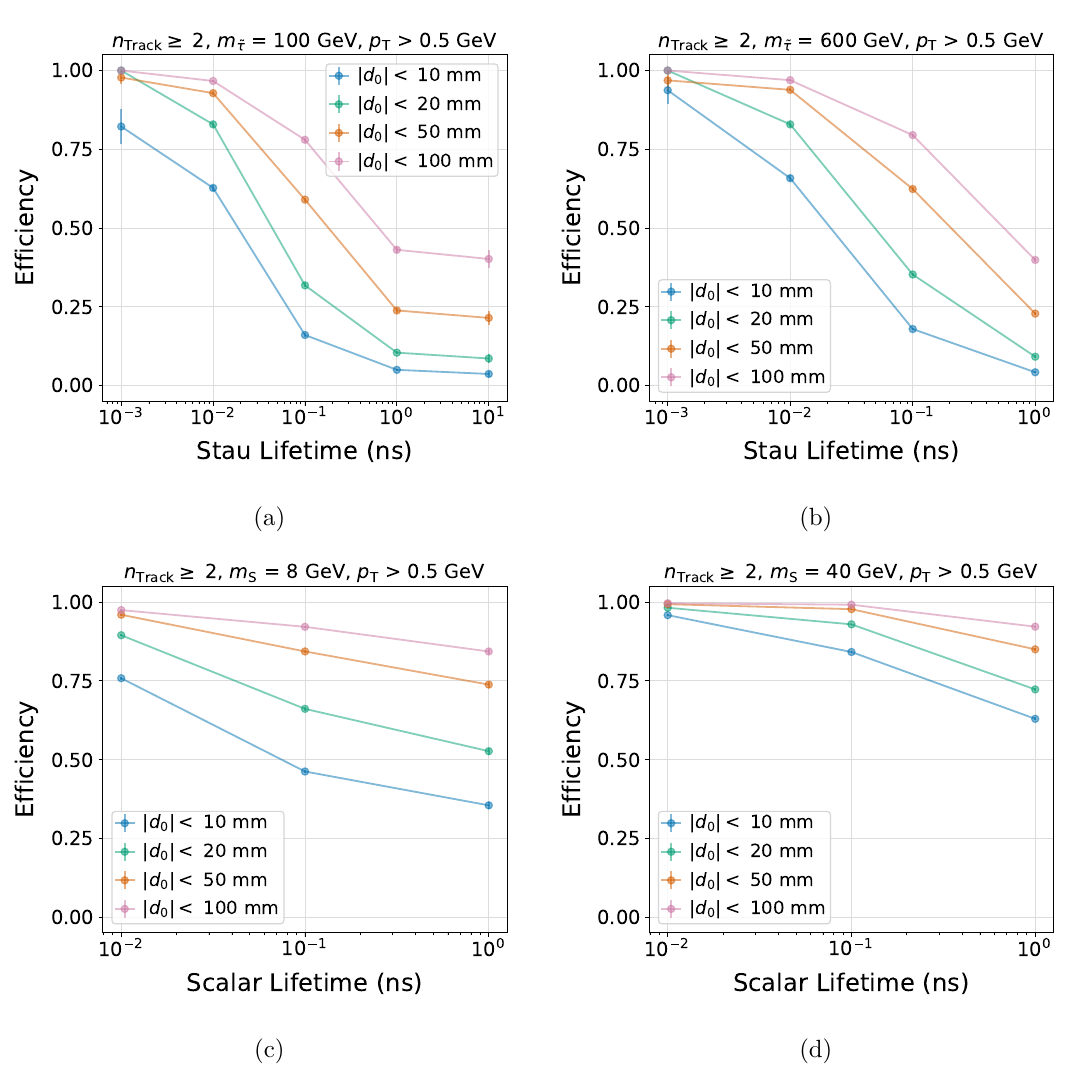
Figure 28. Trigger efficiency as a function of lifetime at a range of maximum track | d 0 | values for staus with masses 100 GeV (c) and 600 GeV (b) and a Higgs portal with scalar masses 8 GeV (b) and 40 GeV (d). Only displaced tracks produced in the long-lived particle decay are considered. Effects of the p threshold are minimized by requiring p T require n 2 Track ≥